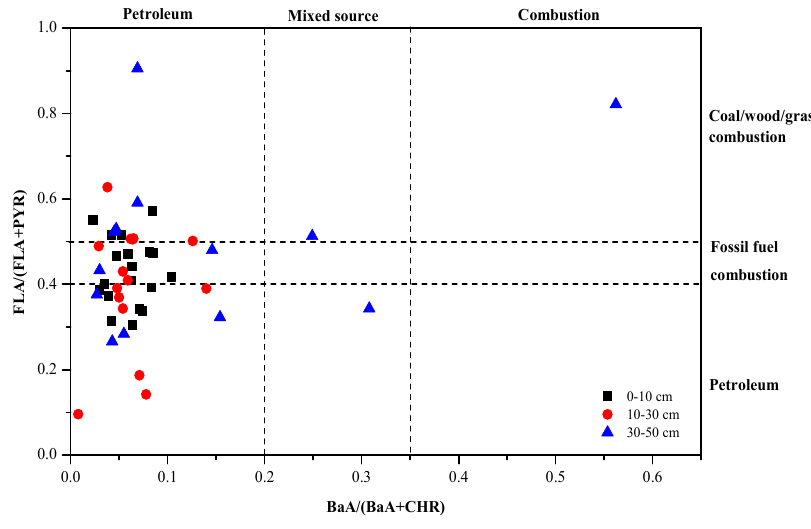
Figure 3. The ratios for BaA/(BaA + CHR) versus FLA/(FLA + PYR) in soils.